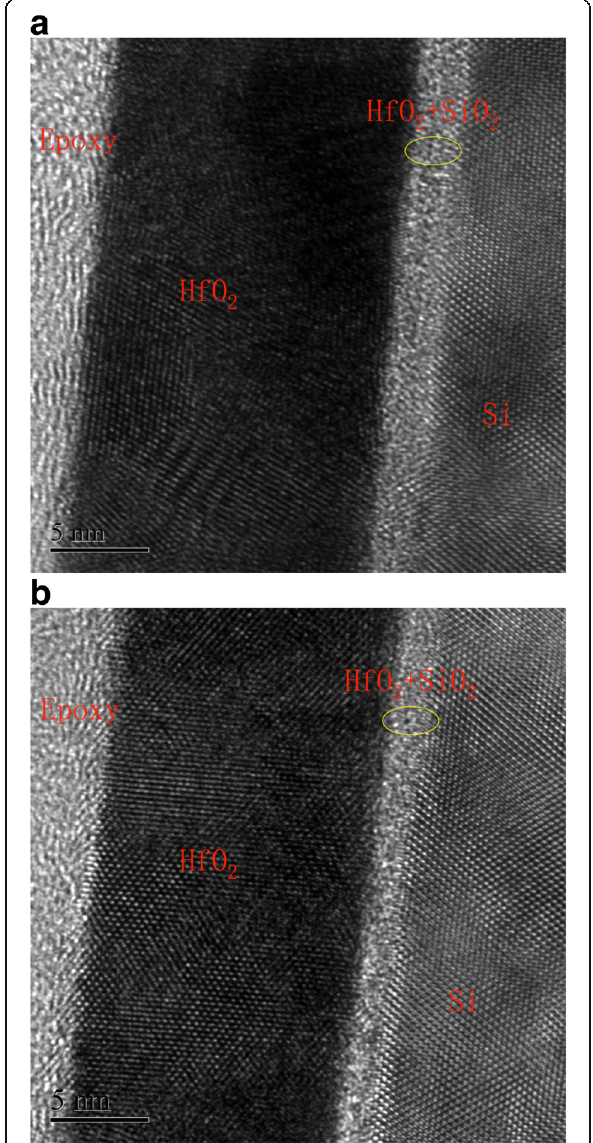
Fig. 3 FE-TEM cross-section analysis of the HfO 2 film annealed at 500 °C ( a ) without and ( b ) with O 2 plasma